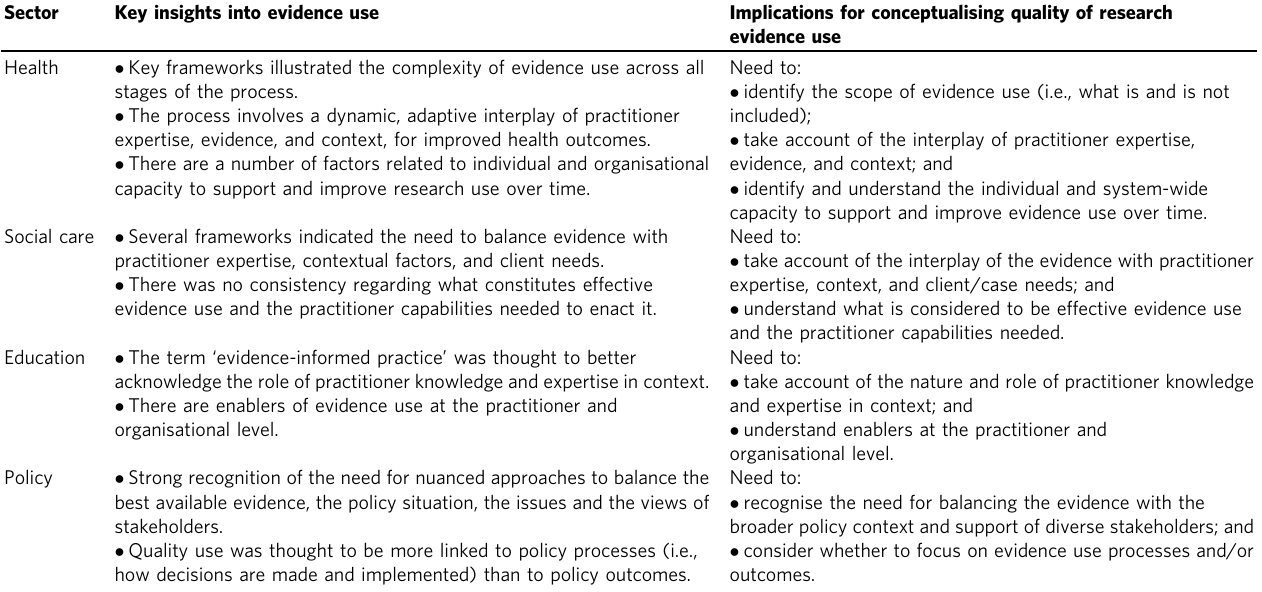
Table 1 Within-sector insights and their implications for conceptualising quality of research evidence use. Sector Key insights into evidence use Implications for conceptualising quality of research evidence